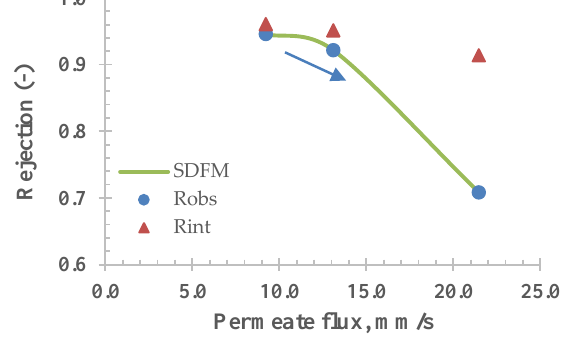
Table 2. The effect of MgCl 2 Concentration on Membrane Salt Permeabilities, P S and Stagnant Layer Salt Permeabilities, P S(  ) obtained as fitting parameters for Eq. 7 Fig 5. Fitting of Observable Rejection Rate experimental (circle) and intrinsic rejection rate (triangular) with SDFM (continuous line) (Testing condition: P = 10 bar, MgCl 2 concentration = 500 – 4000 ppm, CFV = 0.65 m/s, T = 32.66 ± 0.45  C, and pH = 6.42 ±